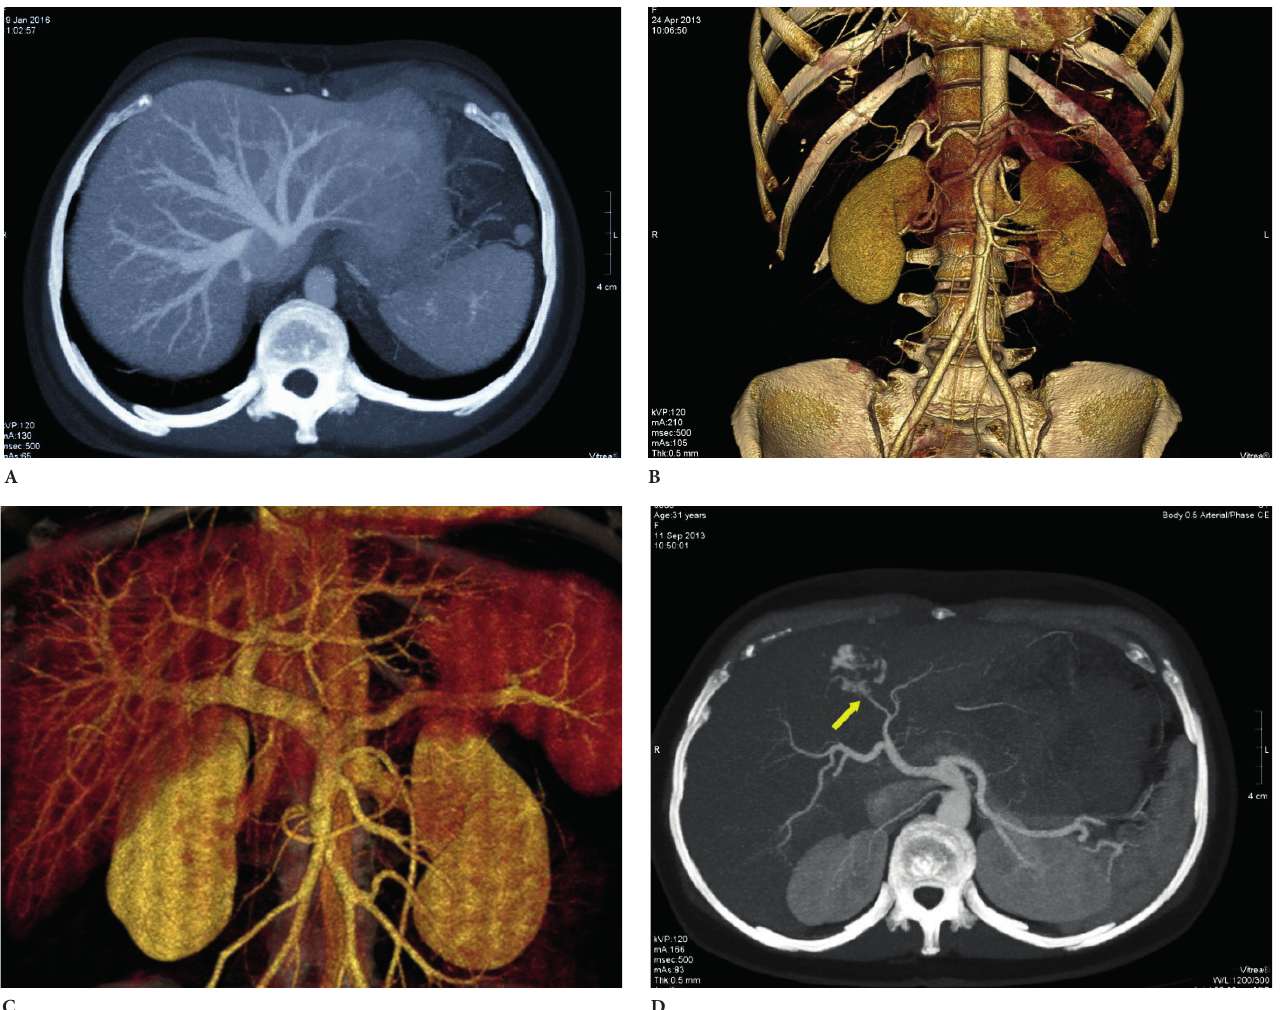
Figure 1- (A) MIP-reconstruction image of normal hepatic veins of the donor in axial projection; (B)